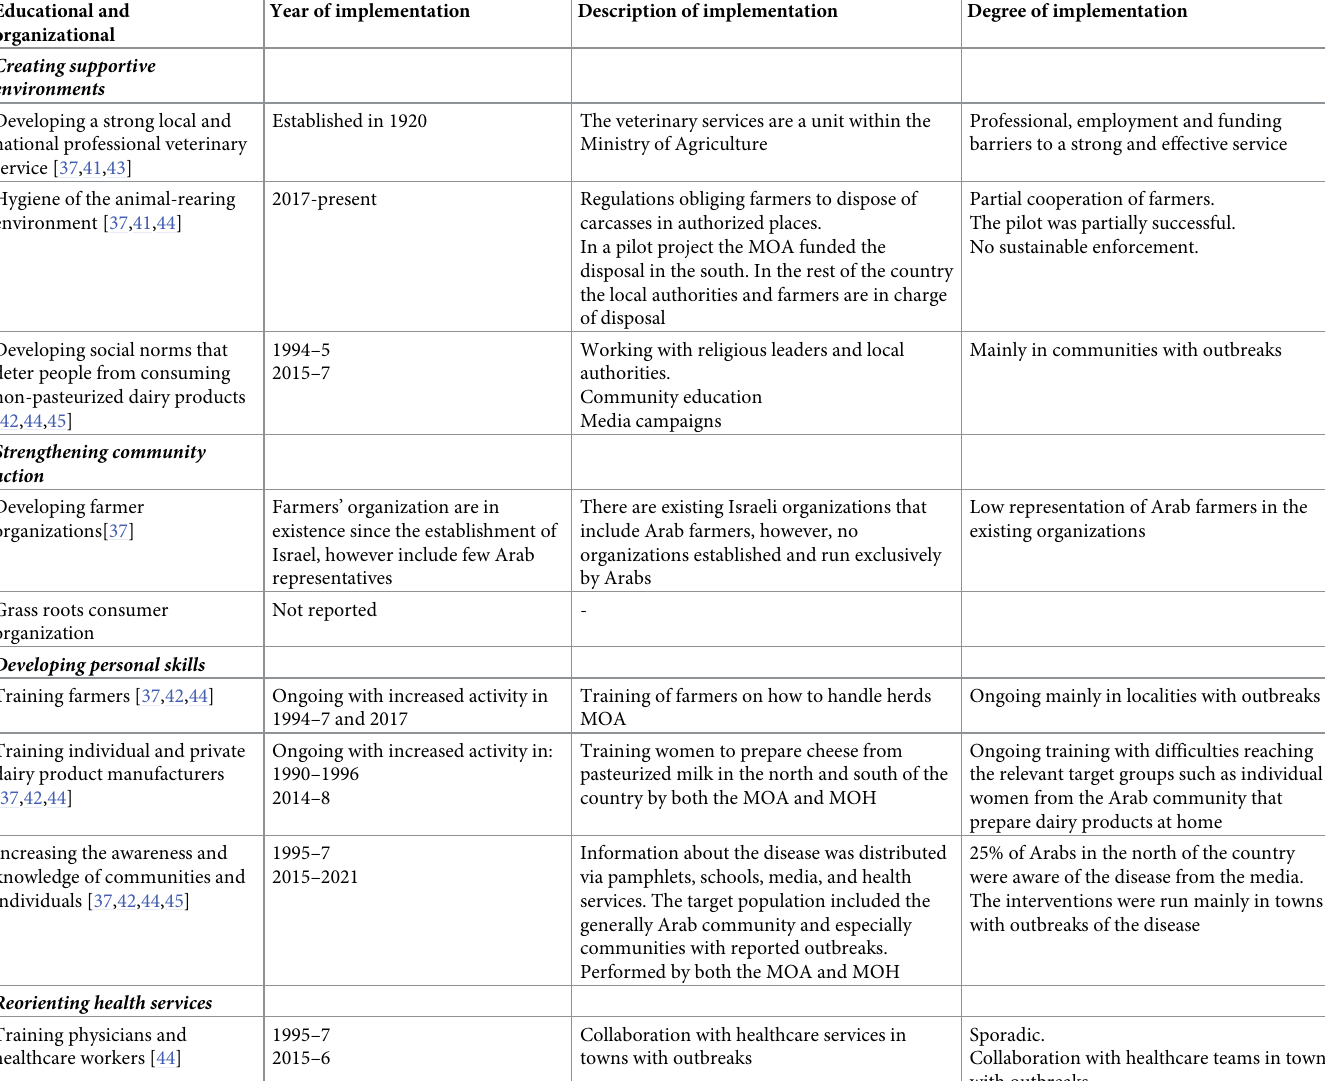
Table 2. Educational and organizational interventions to reduce the burden of brucellosis in Israel. Educational and